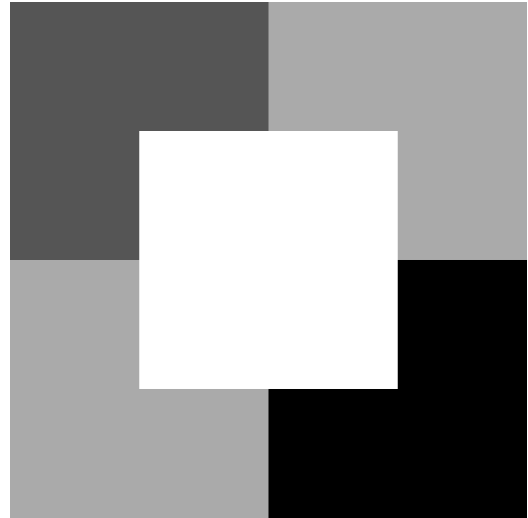
Figure 3. Noiseless Simulated Image in Example 1.